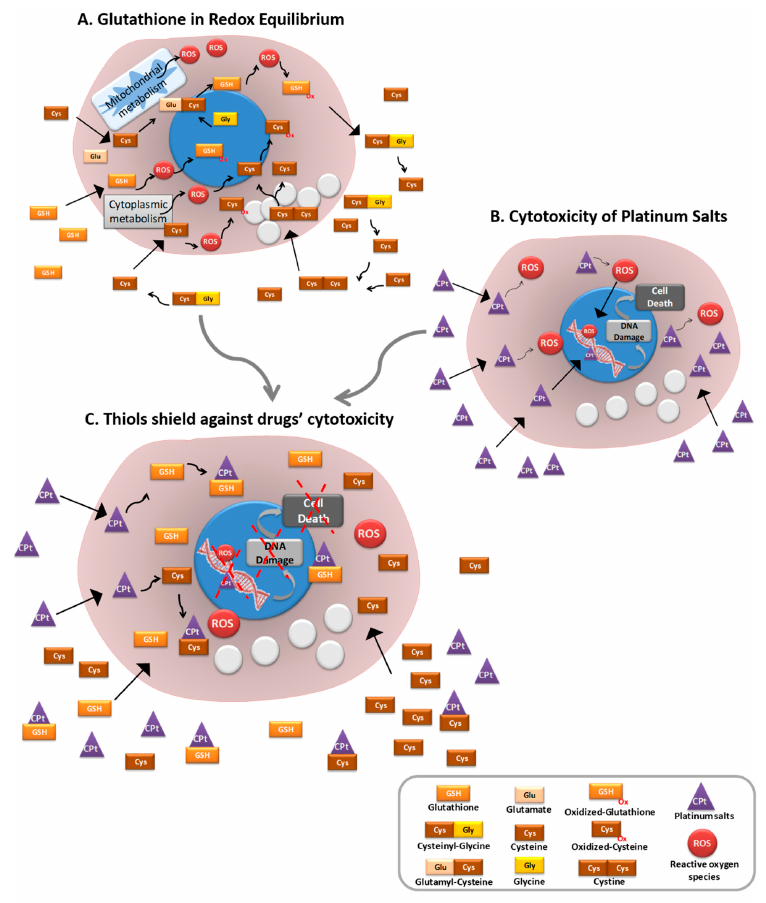
Figure 3. Gluthathione serves as a shield to protect ovarian cancer cells from conventional platinum drugs. ( A ) Glutathione is a pivotal player in the maintenance of redox equilibrium, which allows for homeostatic metabolic flux in a cell. Cysteine is the thiol component of glutathione and can also work as a ROS scavenger. ( B ) Platinum-salt-based drugs are commonly used to treat cancer; their cytotoxic mechanisms induce DNA damage, directly through covalent bonds (adducts) or through the generation of reactive oxygen species (ROS). ( C ) Cancer cells whose metabolism relies on thiols are better protected against platinum-salt-derived drugs. Glutathione and cysteine can bind to platinum salts, abrogating their cytotoxic effect and protecting cancer cells from DNA damage and consequently from death. Thiols allow for the regulation of several metabolic processes central to cancer cells, thus allowing cancer cells’ survival in a stressful and detrimental